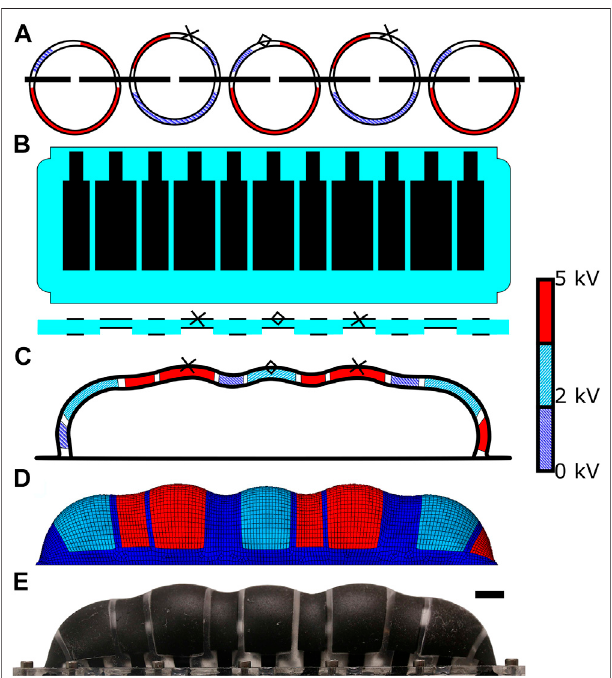
FIGURE 6 | PILA, the phased in fl atable locomotory actuator. (A) — a series of MIDA actuators in a line, the structure PILA is intended to emulate. The crosses and diamonds on (A – C) show points that travel along equivalent paths(see Figure14 ). (B) — PILAinade fl atedstate,showingtherelative sizeandpositionoftheelectrodesandarepresentativecrosssectionshowing the regions of different thickness (not to scale). (C) — the basic layout of PILA when in fl ated showing a cross section through the central axis, DETs are highlighted in various colours to show level of actuation at this point in the cycle. (D) — Finiteelement modelofPILAundergoingastandard walkingcycle using 3 kV peak to peak square wave (with DC offset 3.5 kV) actuation for the “ feet ” electrodes and 5 kV peak to peak (with 2.5 kV DC offset) sine wave actuation for the displacement electrodes. (E) — Physical prototype PILA. Black line is 1 cm in length. See Supplemental Materials for a video of the actuator in motion.